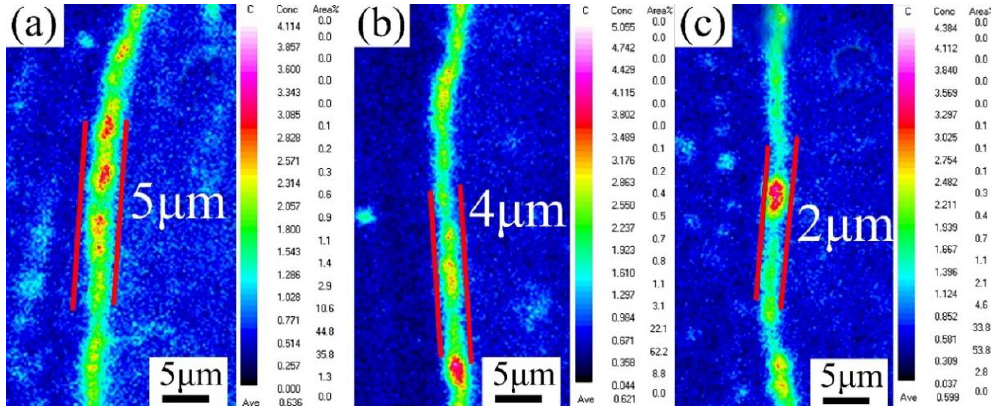
Figure 8. Electron probe micro-analysis (EPMA) for C element distribution in the interface of TA1/Q235B hot-rolled sheets at the temperatures of ( a ) 1003 K ( b ) 1053 K ( c ) 1103 K.